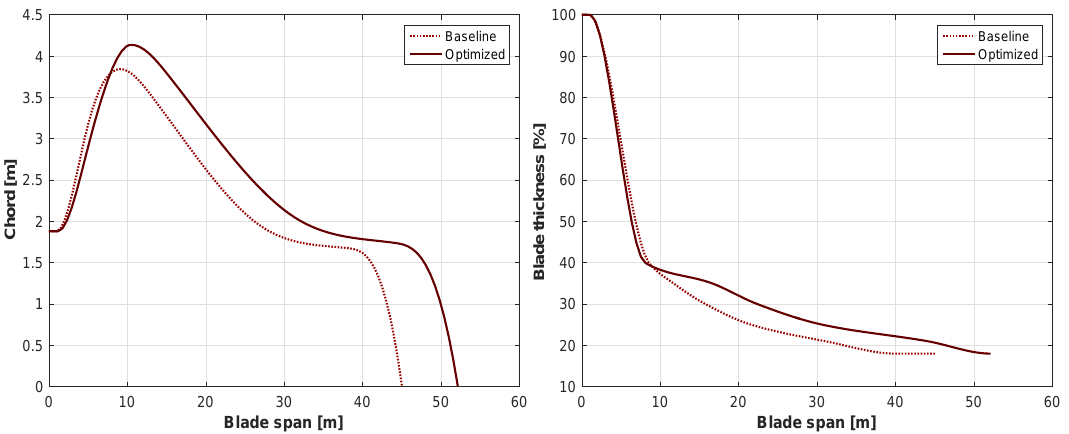
Figure 4. Chord and thickness distributions of the baseline and the optimized 2.2MW wind turbine blades.